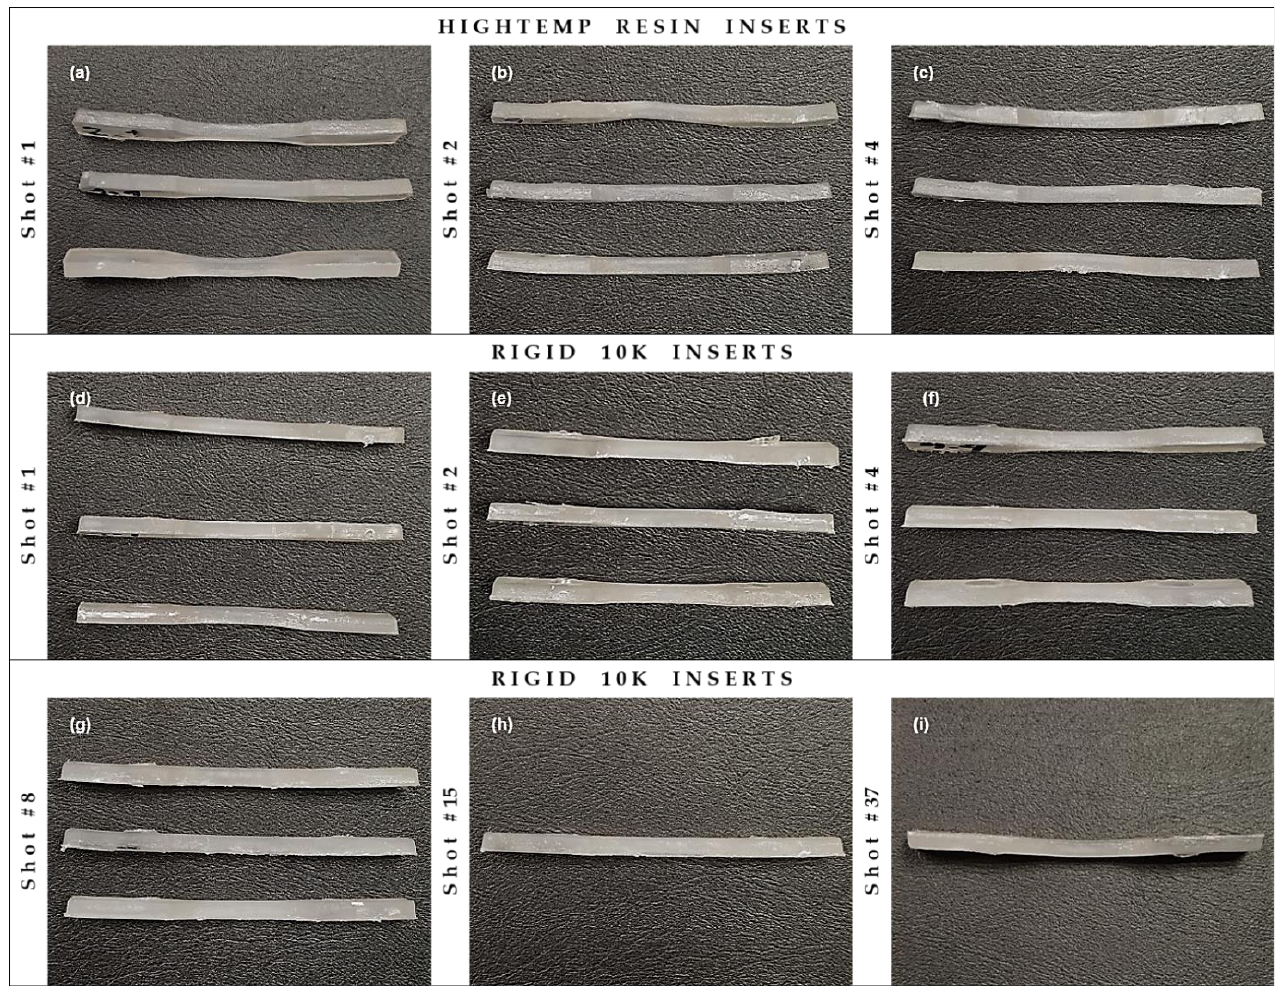
Figure 3. Photographs of three specimens moulded in HighTemp inserts from ( a ) 1st, ( b ) 2nd and ( c ) 4th shots; and specimens moulded in Rigid 10k inserts from ( d ) 1st, ( e ) 2nd, ( f ) 4th, ( g ) 8th, ( h ) 15th and ( i ) 37th shots.